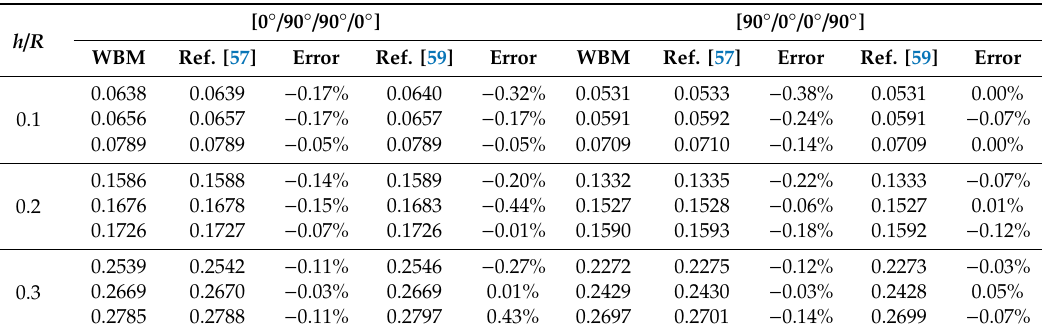
(cid:112) ρ Table 3. Frequency parameters Ω = ω h / G 12 / π for two types of cross-ply composite laminated cylindrical shells with di ff erent thickness to radius ratios under simply-supported boundary conditions ( R = 1 m, L / R = 0.1, E 2 = 1 GPa, E 1 / E 2 = 40, µ 12 = 0.25, G 12 = 0.6 E 2 , G 13 = 0.5 E 2 , G 13 = 0.5 E 2 ,